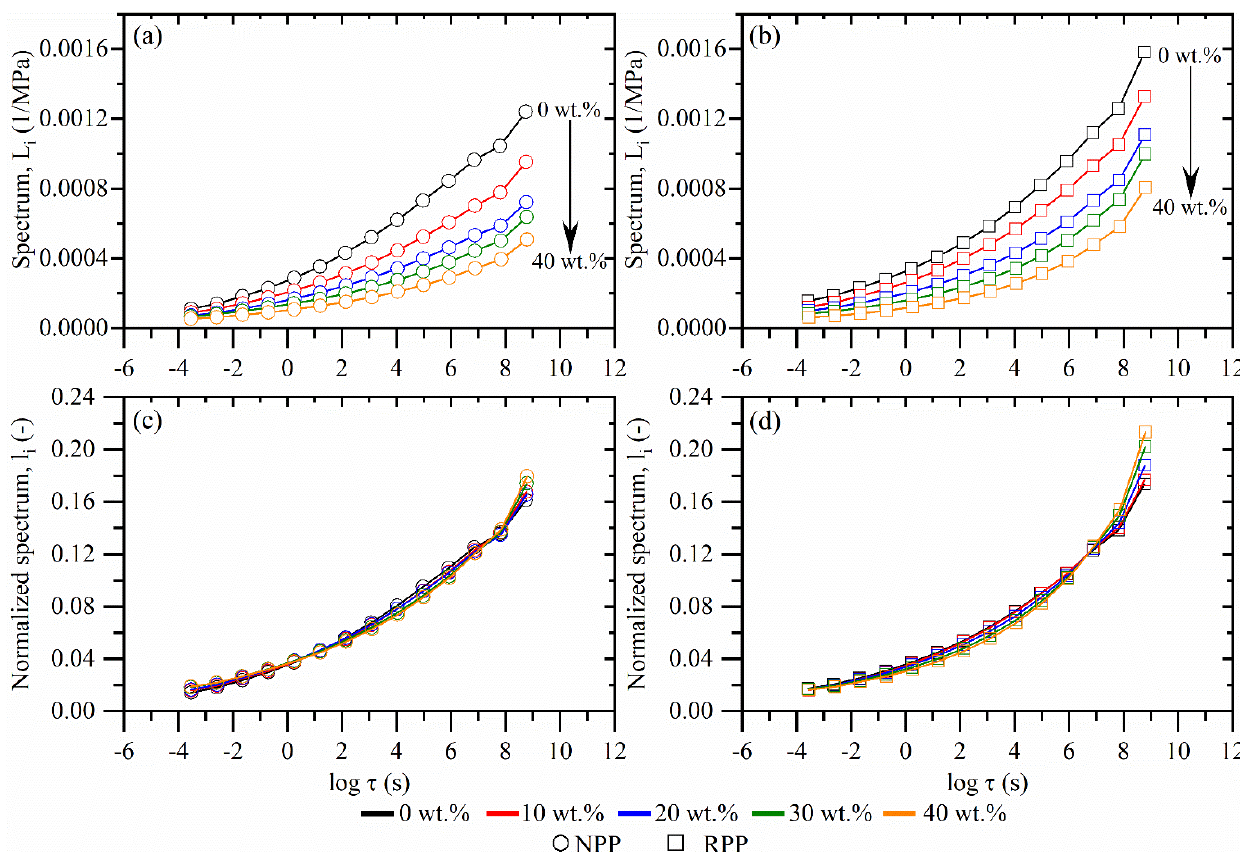
Figure 3. Retardation spectrum of composites with ( a ) neat (NPP) and ( b ) recycled (RPP) matrix. Normalized retardation spectrum of composites with ( c ) neat (NPP) and ( d ) recycled (RPP) matrix.